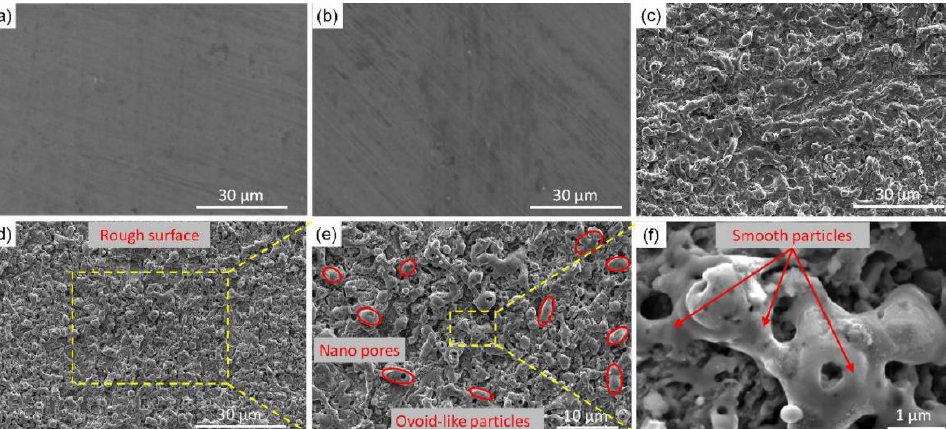
Figure 15. SEM images of ( a ) bare aluminum; ( b ) bare aluminum sample immersed into FAS/ethanol solution for 12 h but in absence of laser treatment; ( c ) bare aluminum sample irradiated into a mixed solution containing distilled water and absolute ethanol but without FAS. The samples immersed in FAS/ethanol solution for 12 h after laser fabrication with scale bar of ( d ) 30 μm, ( e ) 10 μm and ( f ) 1 μm. (Reprinted with permission from Ref. [1]. 2020, Yang, Z.).